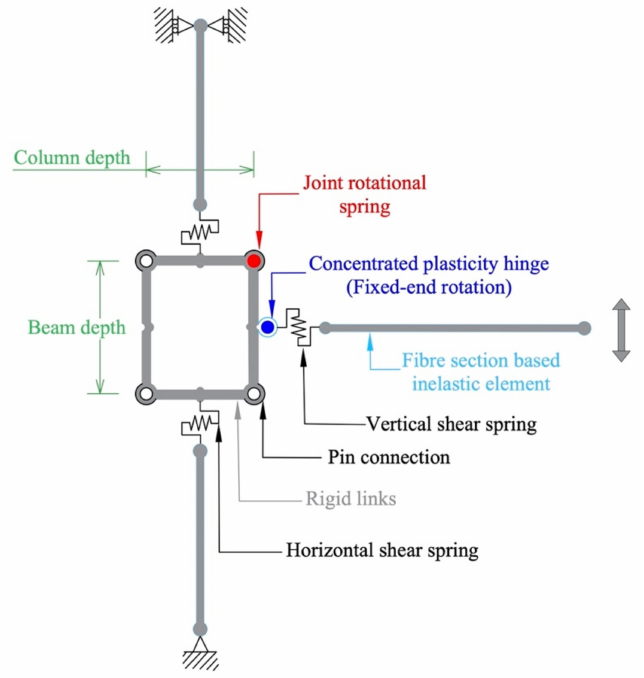
Figure 5. Nonlinear FE-based numerical model for an exterior beam–column joint.